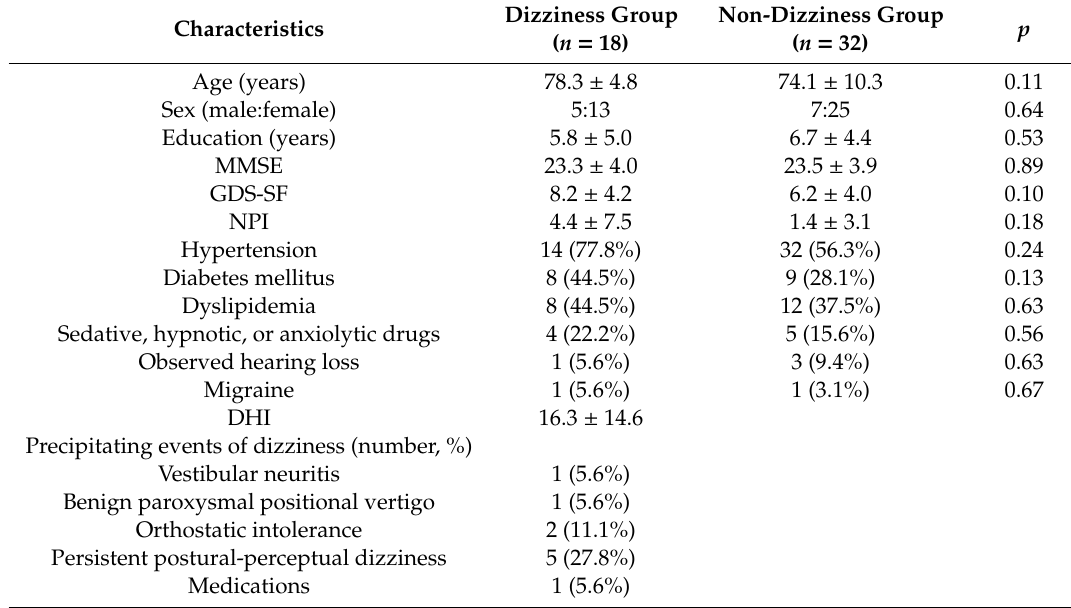
Table 2. Participant demographic and clinical characteristics.